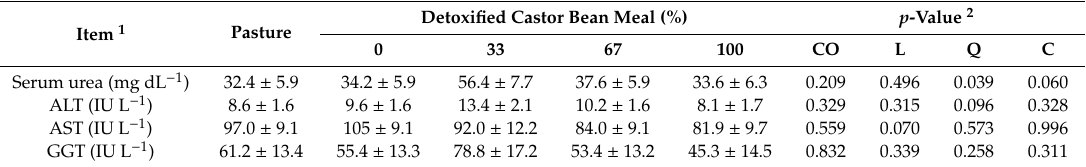
Table 10. Metabolic status of lambs (mean ± SD) supplemented with or without castor bean meal via a creep-feeding